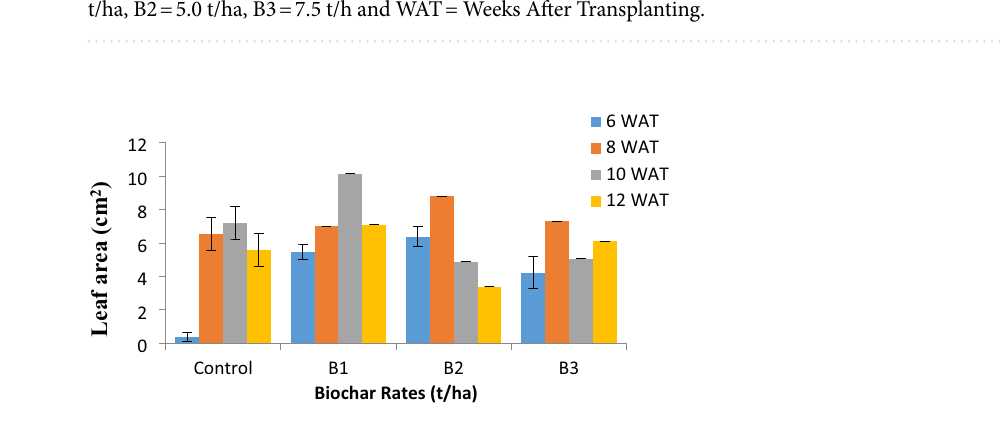
Figure 5. Impact of different rates of biochar on Leaf area (cm 2 ) of tomato at different weeks of planting. B1 = 2.5 t/ha, B2 = 5.0 t/ha, B3 = 7.5 t/h and WAT = Weeks After